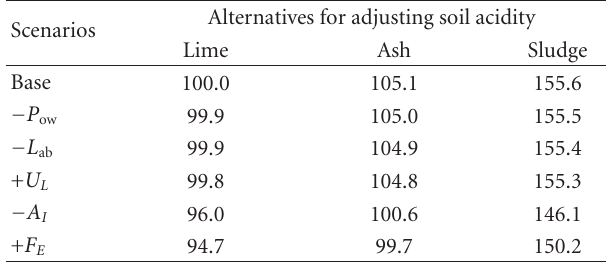
Table 6: Energy demand in the proposed scenarios